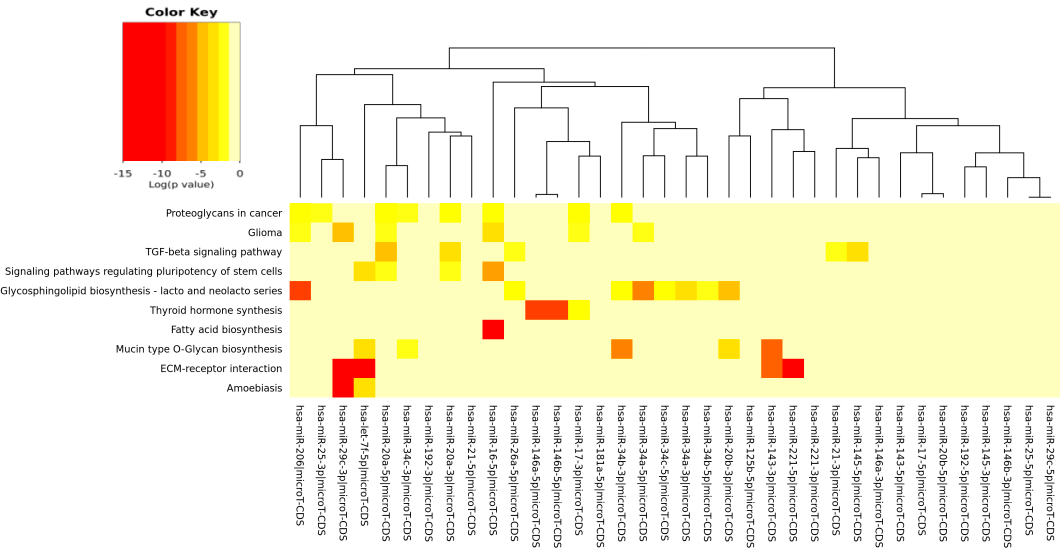
Figure 5. MicroRNAs involved in DDR and modulated by RSV versus the pathways’ heat map. In this plot, heat map calculation is based on absolute p -values. Darker colors represent lower p -values (higher significance). The plot shows microRNAs targeting similar pathway clusters and pathways being targeted by miRNA groups.